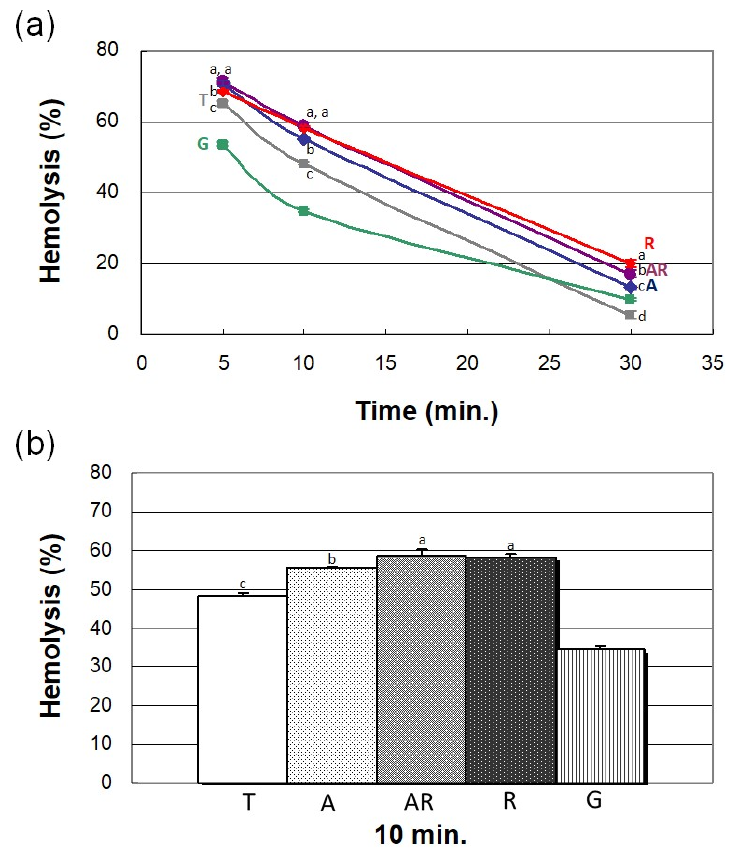
Figure 4. Whole blood coagulation, in terms of hemolysis vs. time, on different test specimens: ( a ) for up to 30 min; ( b ) at 10 min. Coagulation was less extensive on treated Ti specimens than on silica